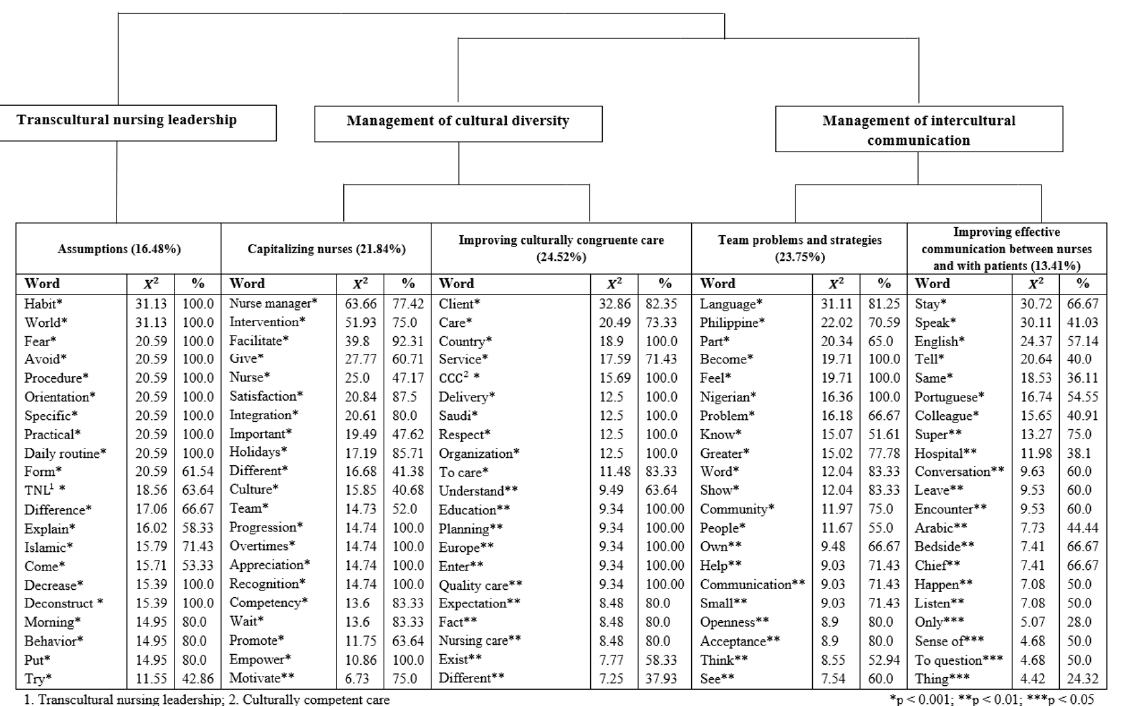
Figure 1. Perceptions of Portuguese nurse leaders about nurse managers’ interventions regarding favorable nursing work environments for multicultural nursing teams and regarding culturally congruent care to patients from different cultural backgrounds: themes, categories and statistically significant words.